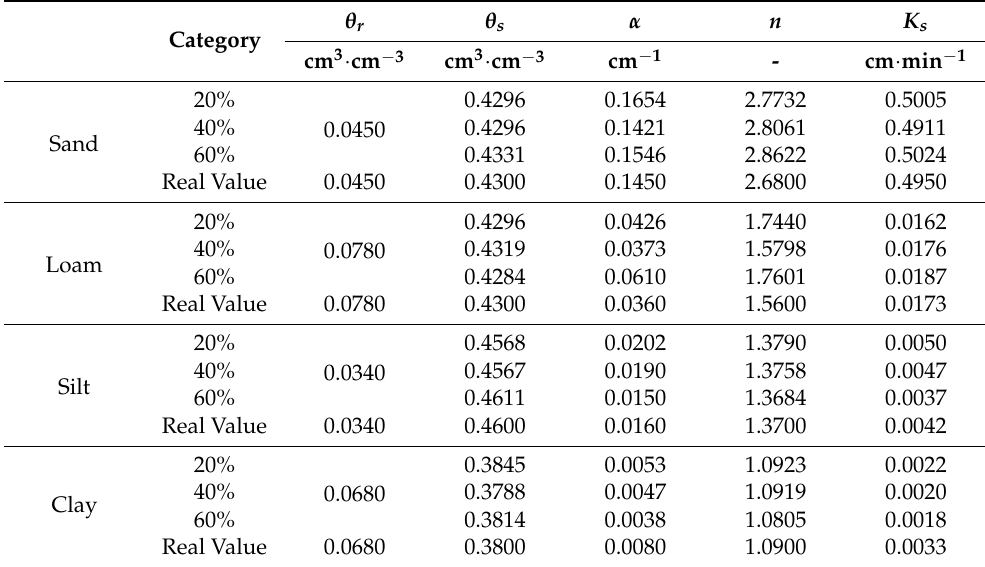
Table 3. Inverted parameters of four typical soils with three initial water content levels.